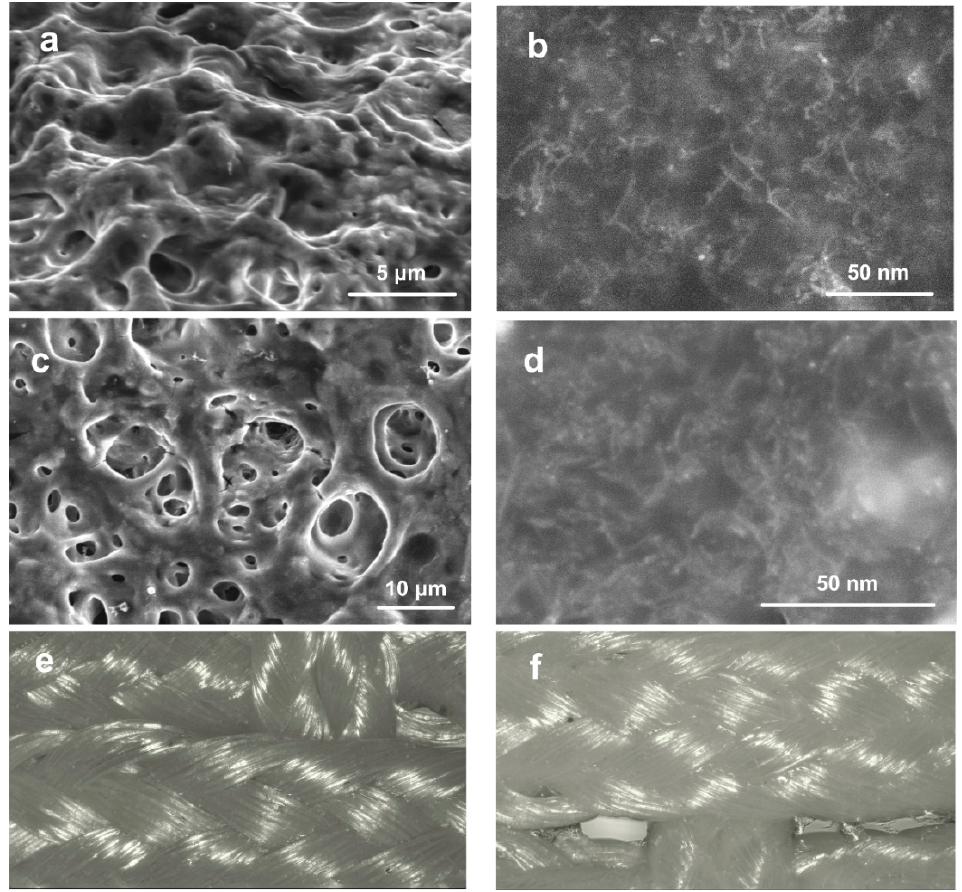
Figure 3. SEM images of ( a ) SWCNT/collagen coating surfaces and ( b ) an enlarged image of the SWCNT frame structure in the collagen matrix; ( c ) The surfaces of the SWCNT/collagen coating; ( d ) SWCNT frame structure in the collagen matrix after long-term contact with blood plasma; ( e ) Optical microscopy of the coating SWCNT/collagen before and ( f ) after long-term contact with blood plasma.